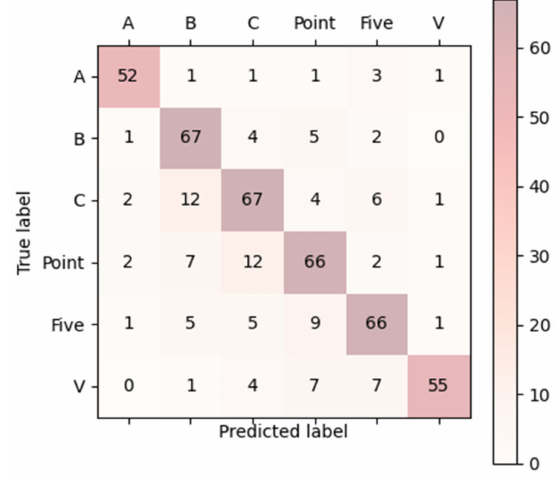
Figure 12. Confusion matrix of Marcel dataset.